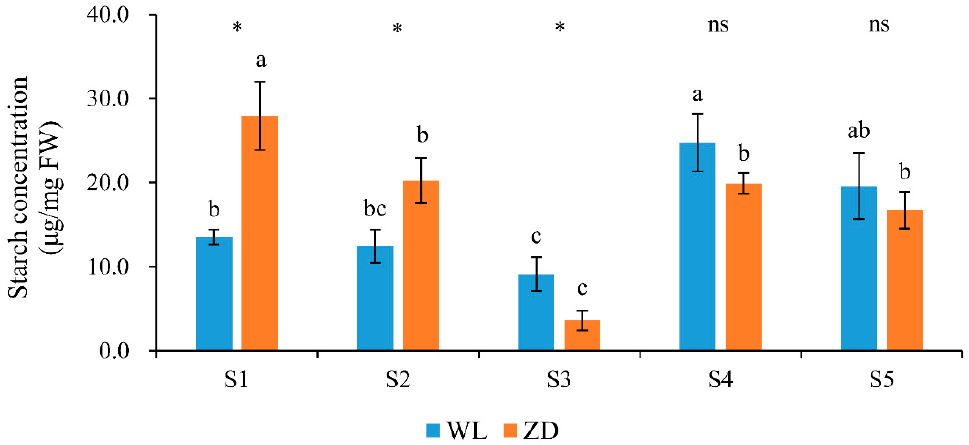
Figure 3. Starch concentrations in alfalfa crowns at five sampling points. Mean values ( n = 5) ± standard errors of the mean are shown. Di ff erent letters (a, b, etc.) above bars indicate a significant di ff erence among the five sampling points (from S1 to S5) in one cultivar ( p < 0.05). The asterisk indicates a significant di ff erence between the two cultivars (S1 vs. S1, S2 vs. S2, etc.) at one same sampling point ( p < 0.05), and the ‘ns’ indicates no significant di ff erence. S1 to S5 are the sampling points after the five phases of the temperature-controlled treatment regime: in phase 1 the temperature was maintained at 18 ◦ C, in phase 2 it decreased to 2 ◦ C, in phase 3 it was maintained at 2 ◦ C and − 2 ◦ C for two weeks, in phase 4 it increased to 18 ◦ C, and in phase 5 it decreased to 2 ◦ C. WL = WL440HQ, ZD = ZhaoDong.